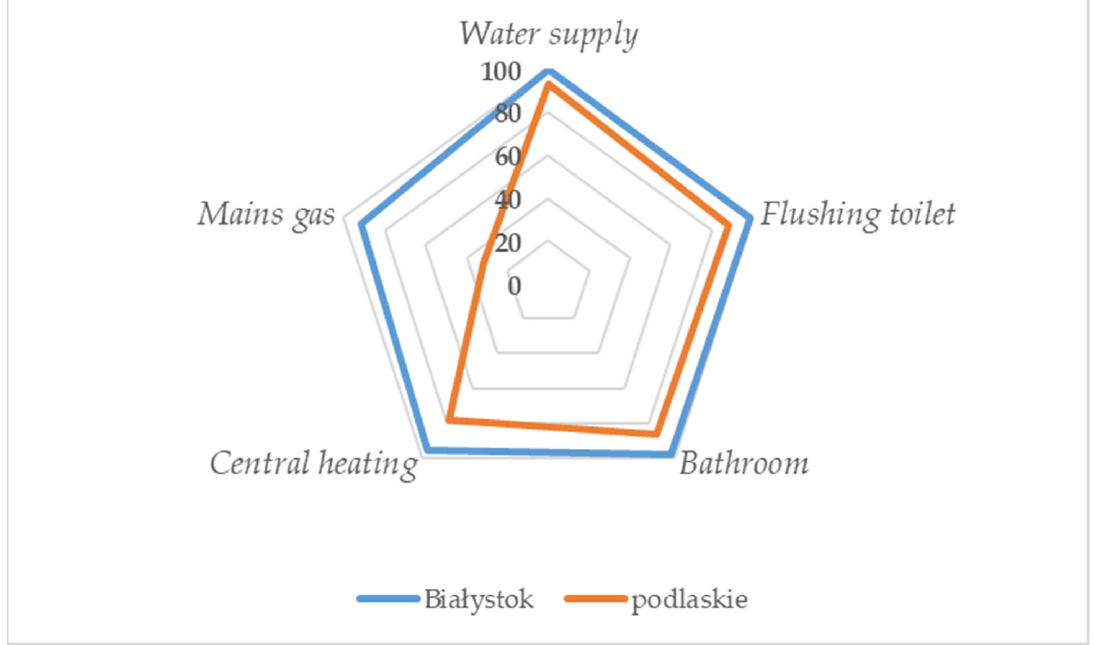
Figure 3. Indicators of housing infrastructure quality in Bia ł ystok and the Podlaskie Province.